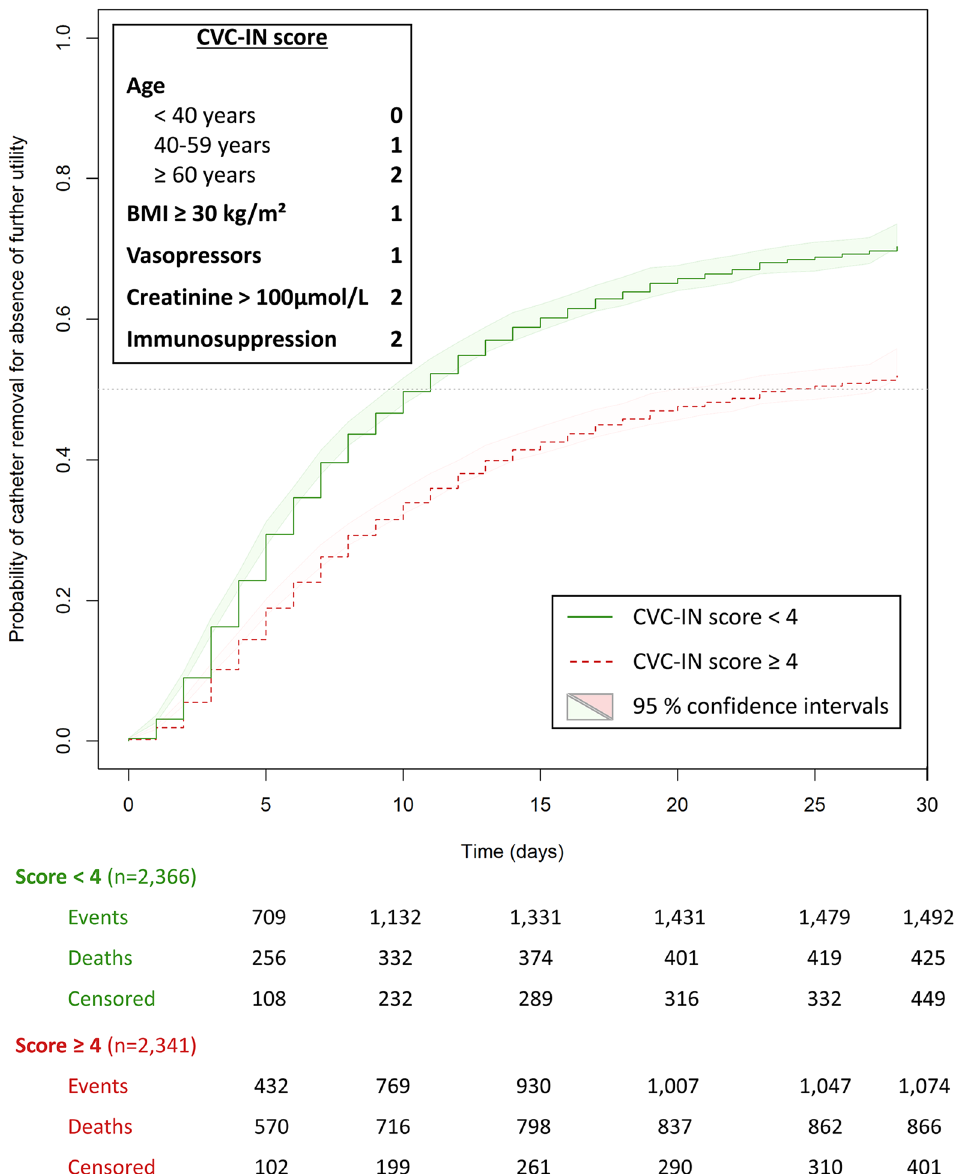
Fig. 3 Cumulative incidence of catheter removal for absence of further utility according to the CVC‑IN score risk‑categories in the overall cohort ( n 4707). BMI body mass =